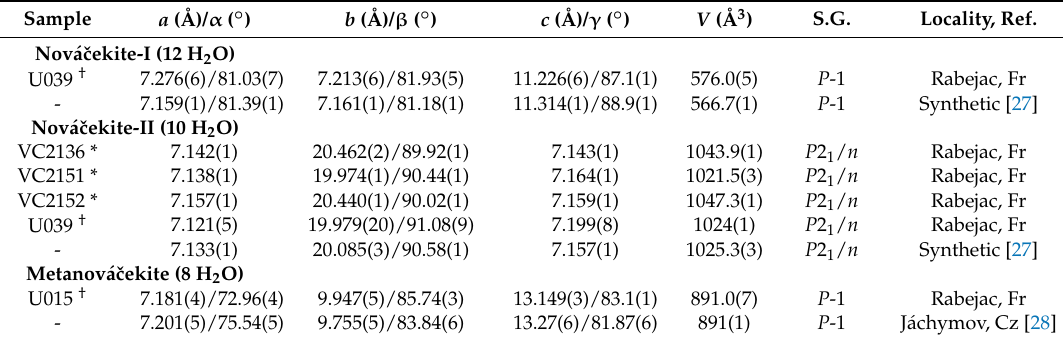
Table 5. Refined unit-cell parameters of nov á ˇcekite-II, nov á ˇcekite-I and metanov á ˇcekite.